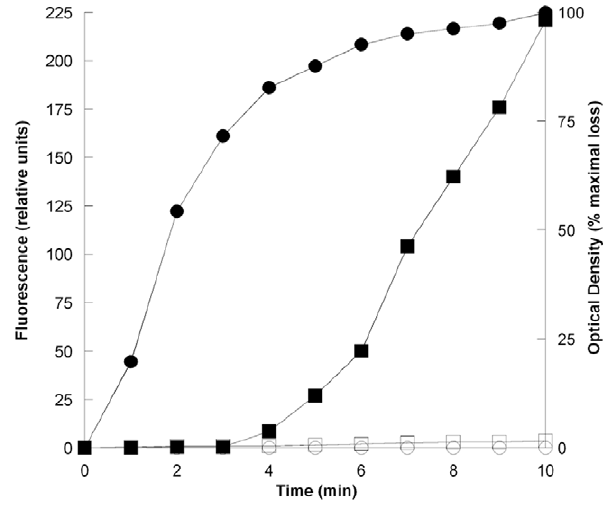
S/N, signal-to-noise ratio. d Germinants: For B. anthracis and B. cereus , 2.5 mM L-alanine together with